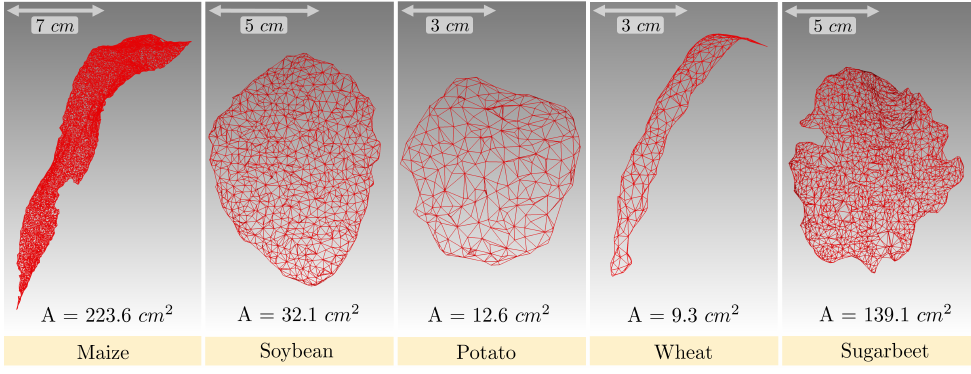
Figure 12. Estimated triangle meshes and computed leaf areas for the leaf point clouds in Figure